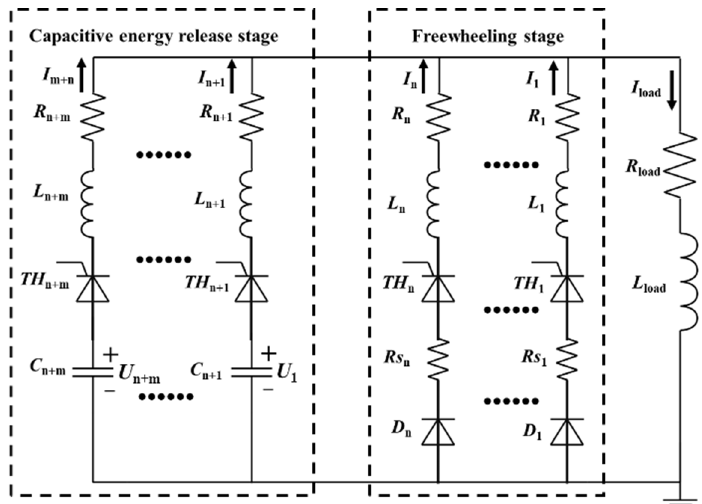
Figure 3. The simplified circuit.